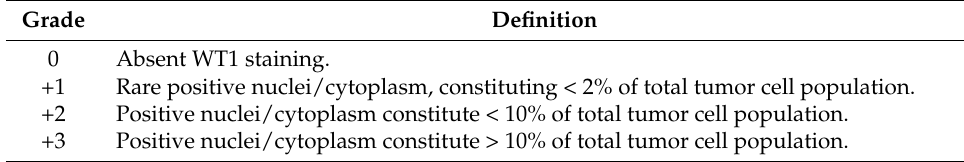
Table 2. WT1 quantitative expression protocol.